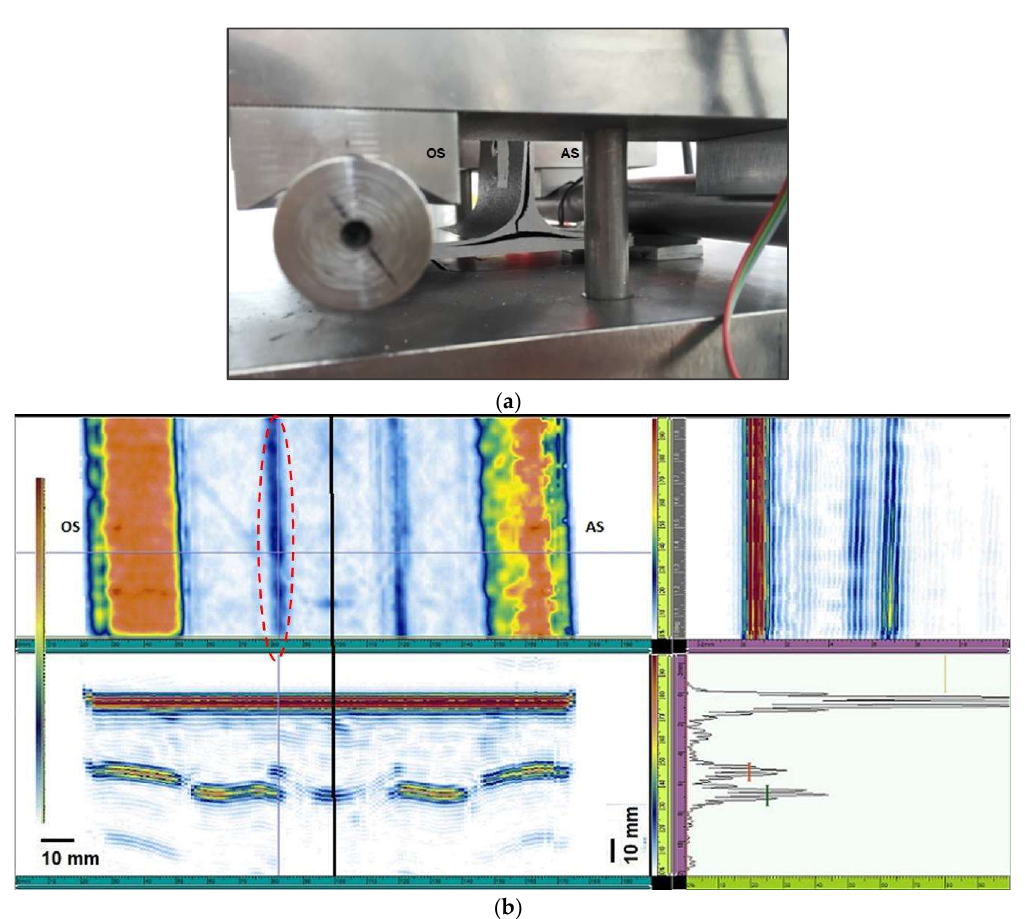
Figure 12. ( a ) Specimen 7 after delamination fracture; ( b ) UT images before the breaking; the red circle shows the continuous defected area.